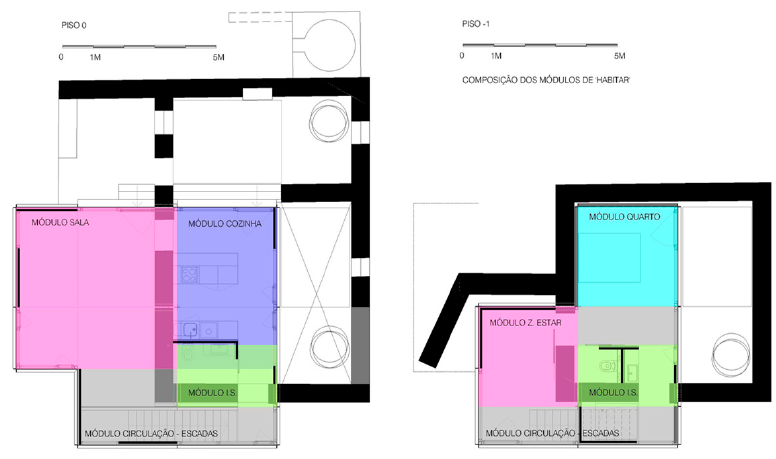
Figure 2. Schemes of the composition of the “living” modules (plans).